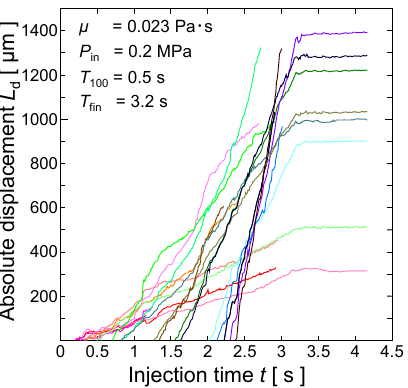
Figure 17. Time evolution of L d with injection pressure of P in = 0.2 Pa.